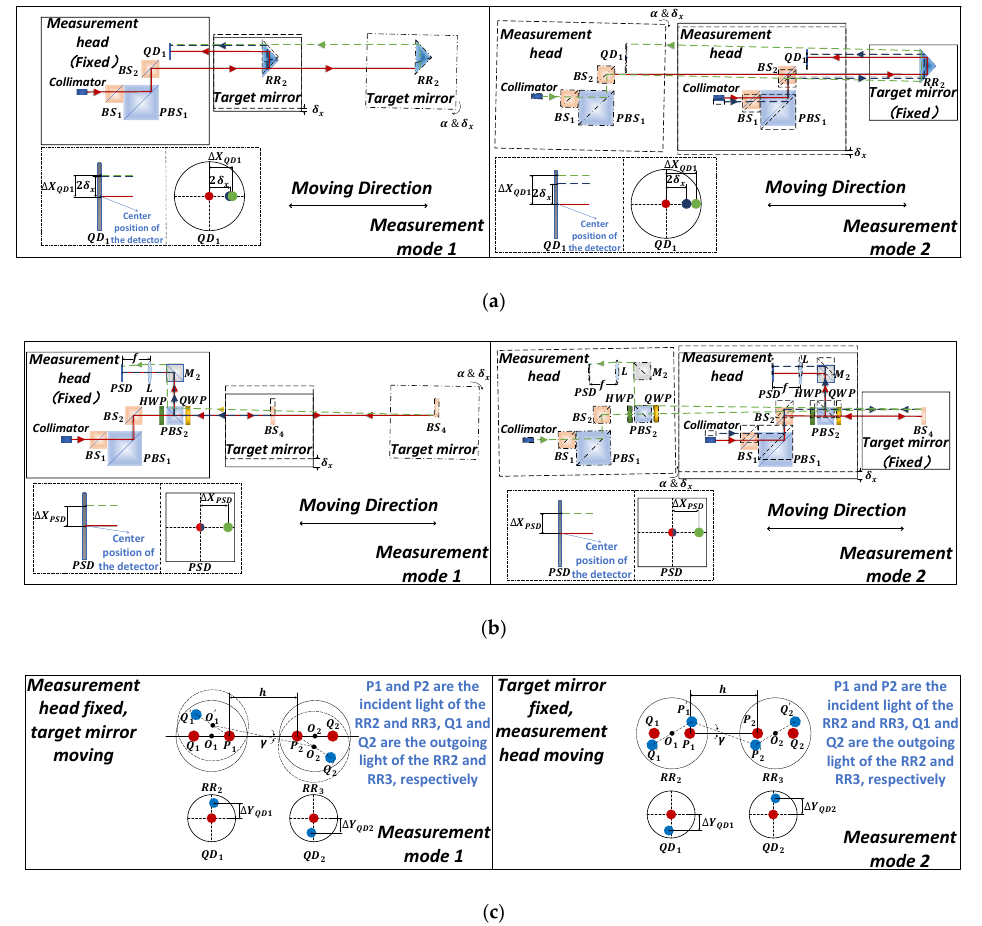
Figure 3. Principles of straightness and angular error measurement under two different measurement modes. ( a ) Straightness error measurement; ( b ) Yaw (pitch) error measurement; ( c ) Roll error measurement.